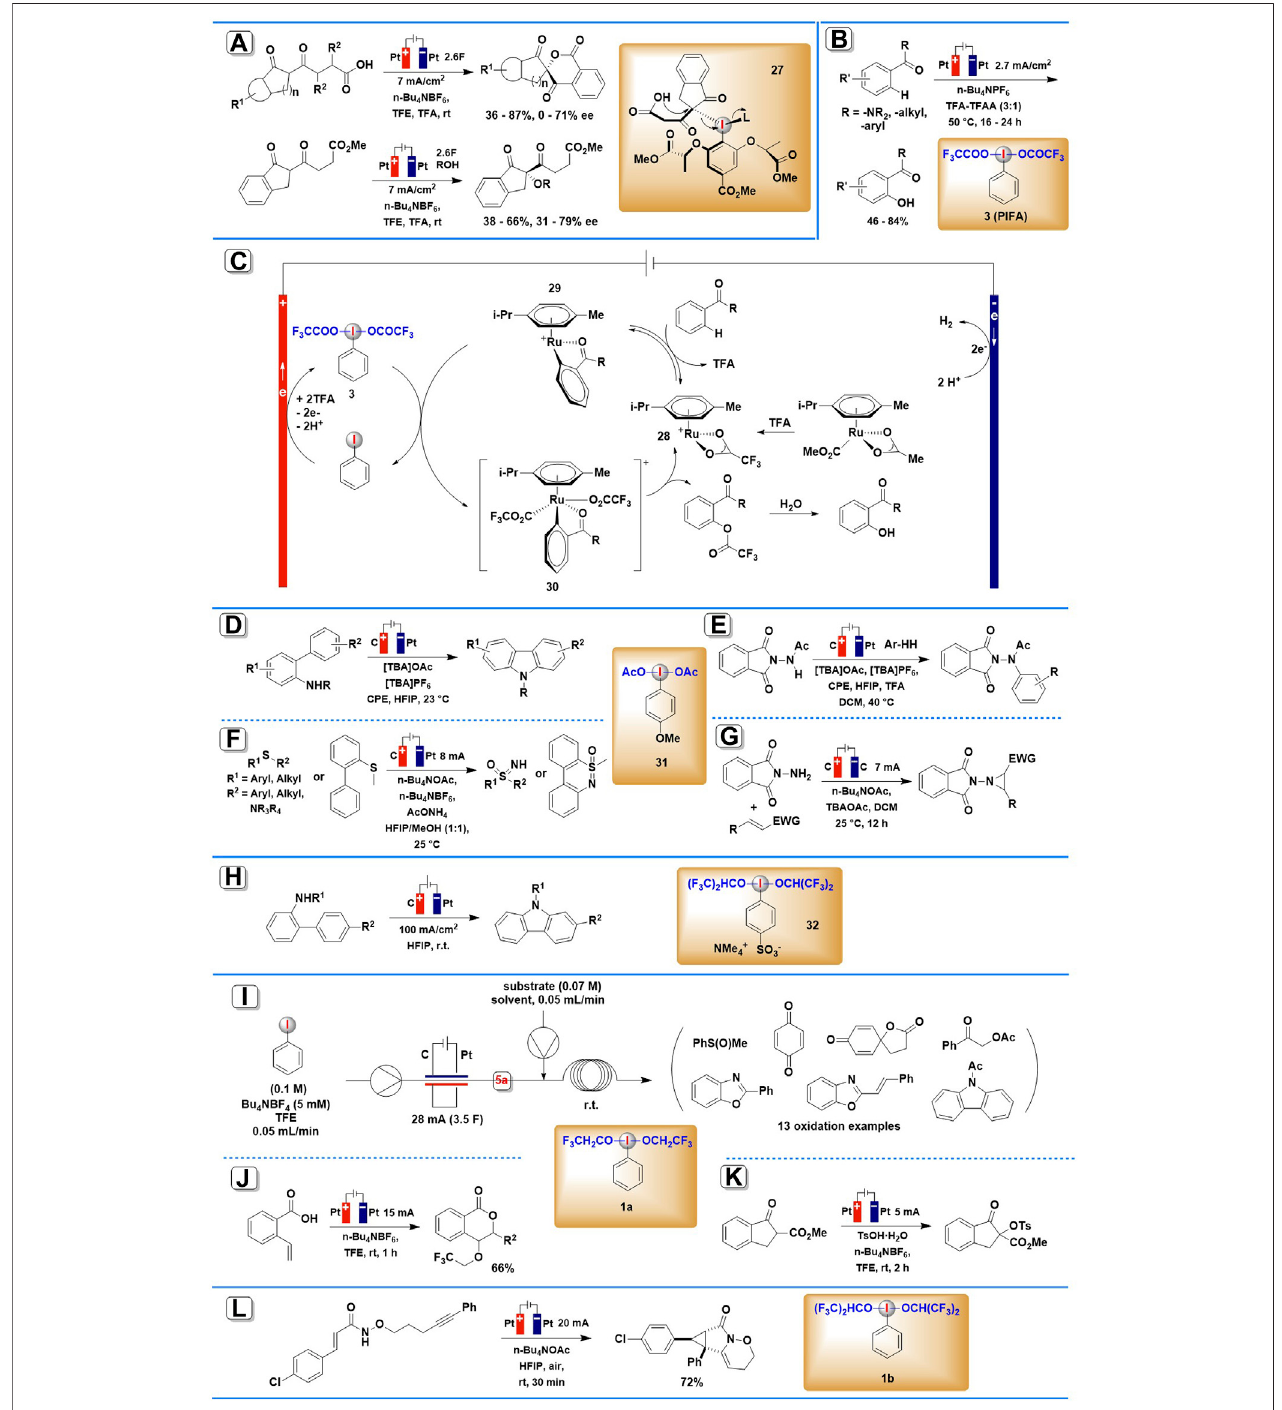
SCHEME 2 | Organic transformations mediated by anodically generated (diacyloxyiodo)arenes or (dialkoxyiodo)arenes. (A) The asymmetric spirolactonization mediated by anodically generated chiral iodine (III) intermediate. (B) The reaction and the possible mechanism (C) of iodine(III)/Ruthenium complexes electrocatalyzed C – Hoxygenation. (D,E) TheelectrocatalyticC-NcouplingmediatedbyanodicallygeneratedArI(RCOO) 2 . (F) TheelectrochemicalsynthesisofNH-sulfoximinesandNH- sulfonimidamides mediated by anodically generated ArI(RCOO) 2 . (G) The electrochemical aziridination mediated by anodically generated ArI(RCOO) 2 . (H) The intramolecular oxidative C-N bond formation mediated by anodically generated (dialkoxyiodo)arene. (I – K) Organic transformations mediated by anodically generated